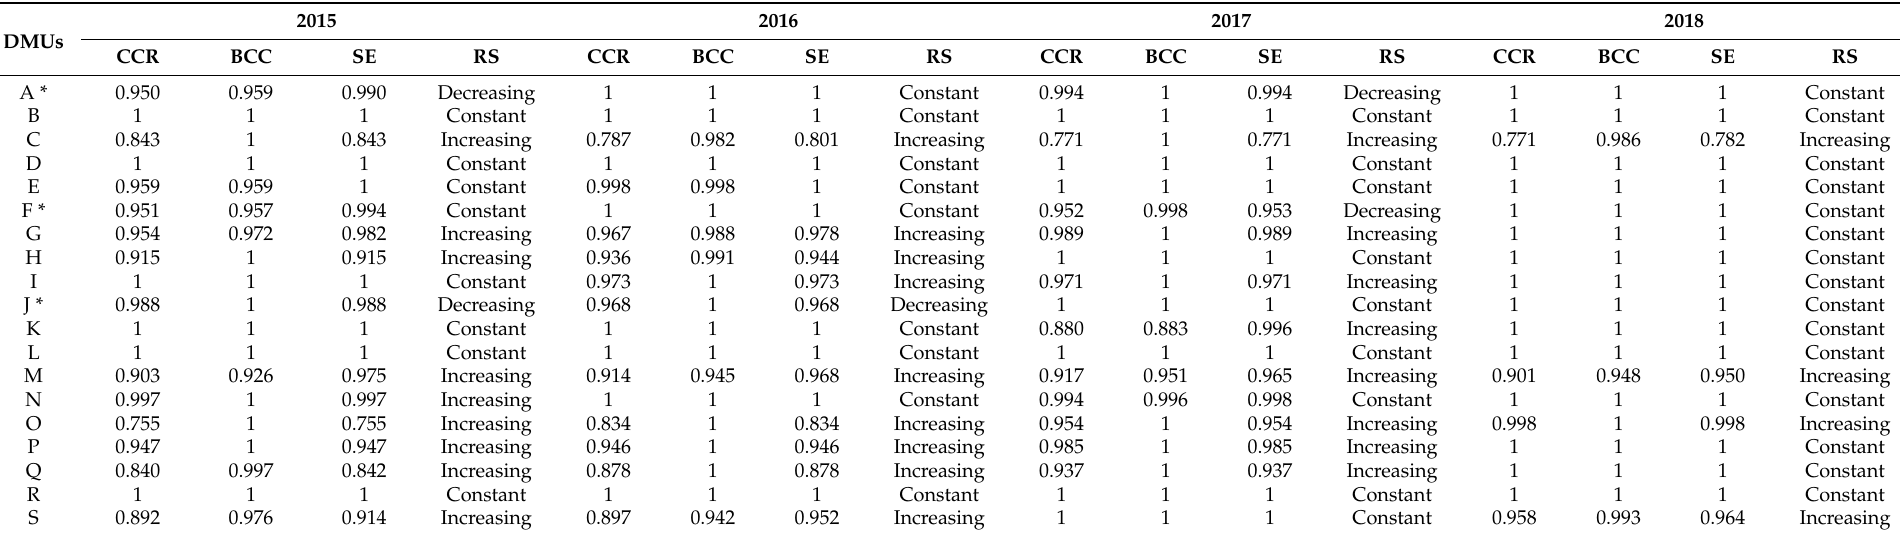
Table 5. The DEA relative efficiency value of each tertiary hospital in